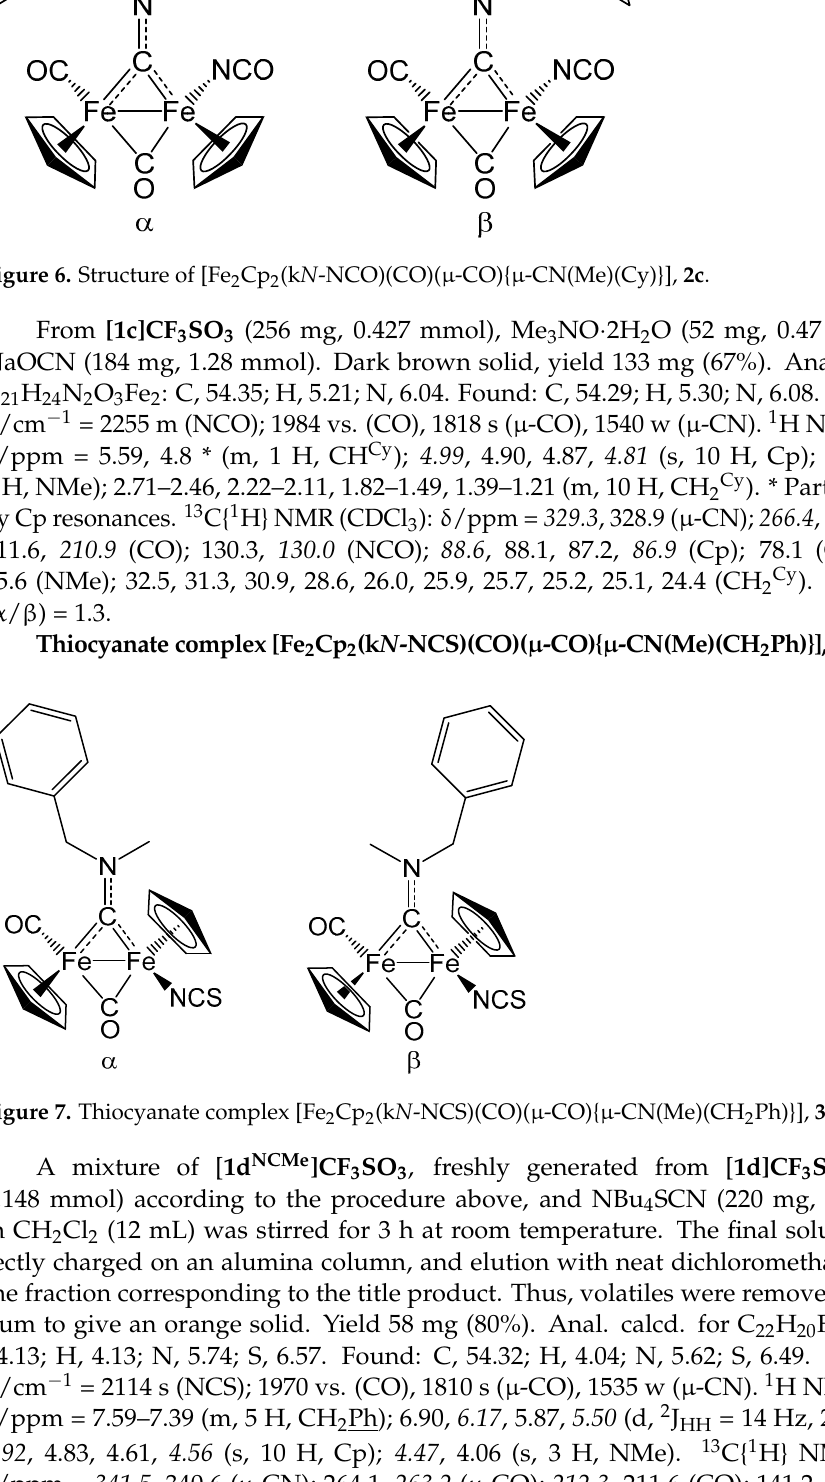
/cm − 1 = 2114 s (NCS); 1970 vs. (CO), 1810 s ( µ -CO), 1535 w ( µ -CN). 1 H NMR (CDCl 3